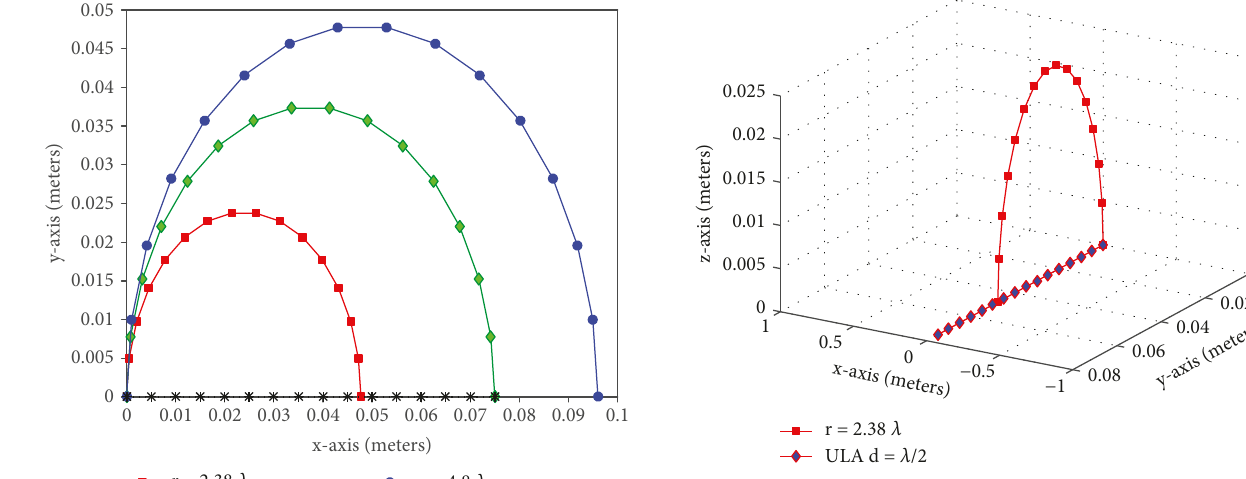
Figure 5: Element positions for the ULA in fl at and bent (in the yz -plane) positions.